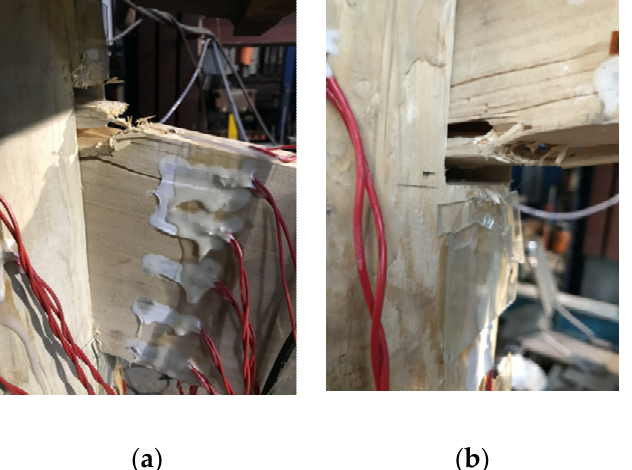
Figure 15. Failure modes of specimens BS2~BS3: ( a ) tensile crack failure at the top of the tenon neck;